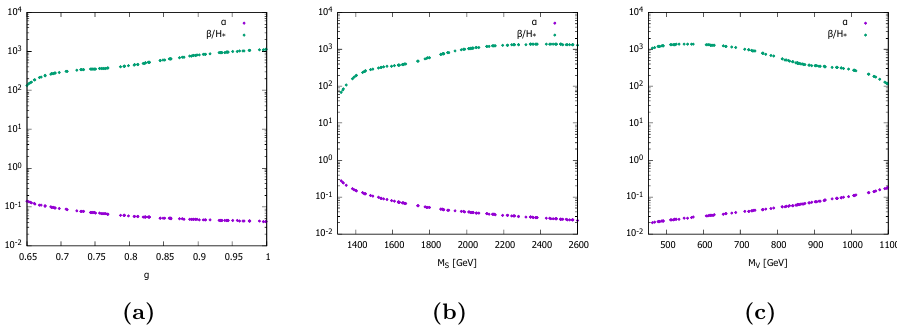
Figure 7. Variation of α and β/H ∗ respect to parameter space. In all digrams the fixed parameters are: M = 1800 GeV , M = 800 GeV , g = 0 . 85 S V